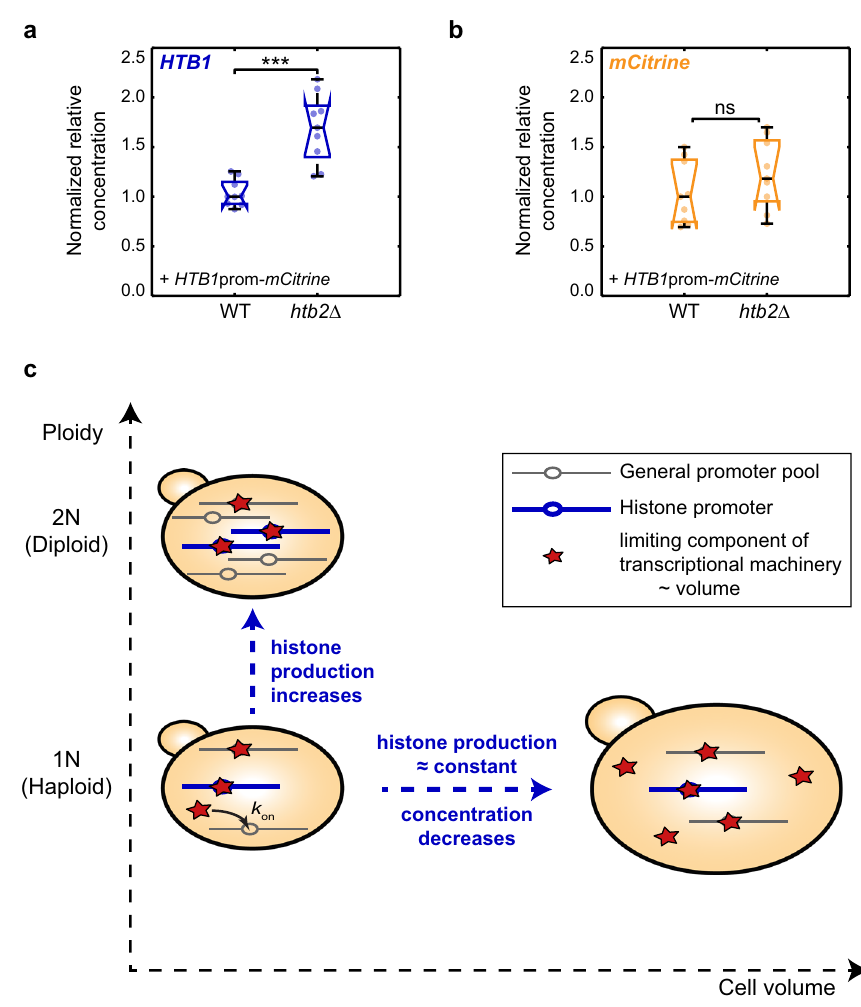
Fig. 8 Histone promoters can couple gene expression to genome content. a , b Relative HTB1 ( a ) and mCitrine ( b ) mRNA concentrations (normalized on RDN18 ) for a wild-type haploid strain carrying an additional HTB1 promoter driving mCitrine expression, and a htb2 Δ in the same background, measured by RT-qPCR. Concentrations are normalized on the respective median concentration in the wild-type. Biological replicates are represented as colored data points (circles, n = 9), colored boxes highlight the 25- and 75-percentiles and whiskers extend to the minimum and the maximum of the distributions. Black, horizontal lines indicate the median of the biological replicates, notches indicate the 95% con fi dence interval. Signi fi cances were tested using a two- tailed, two-sample t test at a con fi dence level α ¼ 0 : 05; *** p HTB1 ¼ 3 : 5 (cid:3) 10 (cid:1) 4 . c Illustration of the mechanism identi fi ed in this study. Through template- limited transcription, cells can quantitatively couple histone production to DNA content even though total biosynthetic capacity is linked to cell volume. This results in a decrease of histone concentration with increasing cell volume and an increase with β -estradiol-inducible promoter system 19 . Speci fi cally, this inducible promoter system consists of a β -estradiol-dependent, arti fi cial transcription factor, which can bind an arti fi cial promoter. This promoter is then used to induce WHI5 expression. To ensure that β -estradiol addition itself has no effect on cell growth, we grew cell cultures of a non-inducible WHI5 haploid strain and cell cultures of a whi5 Δ haploid strain, containing the β -estradiol-dependent, arti fi cial transcription factor, but no copy of WHI5 . We then added β -estradiol to those cultures and quanti fi ed the mean cell volumes after 24 h of growth in the presence of β -estradiol, by measuring the cell volume distributions using a Coulter counter (Beckman Coulter, Z2 Particle Counter). Finally, we compared the mean cell volumes to the mean cell volumes obtained from cell populations without β -estradiol addition (Supplementary Fig. 3a). In addition, we performed reverse-transcription-qPCR (RT-qPCR) on cell populations with and without β -estradiol addition and compared the obtained mean values for several genes (Supplementary Fig. 3b, c). For the non-inducible WHI5 haploid strain, we could not identify a signi fi cant deviation of the population means between the cell populations with and without β -estradiol addition. For the whi5 Δ haploid strain, containing only the β -estradiol- dependent, arti fi cial transcription factor, we observed a slight but signi fi cant reduction of the relative mean mRNA concentrations of HTA2, HHF2 and HHO1 at 30 nM compared to 0nM β -estradiol, which was consistent with a slightly increased mean cell volumes at 30 nM β -estradiol. In contrast, performing the same experimental procedure on cell cultures of an inducible WHI5 haploid strain leads